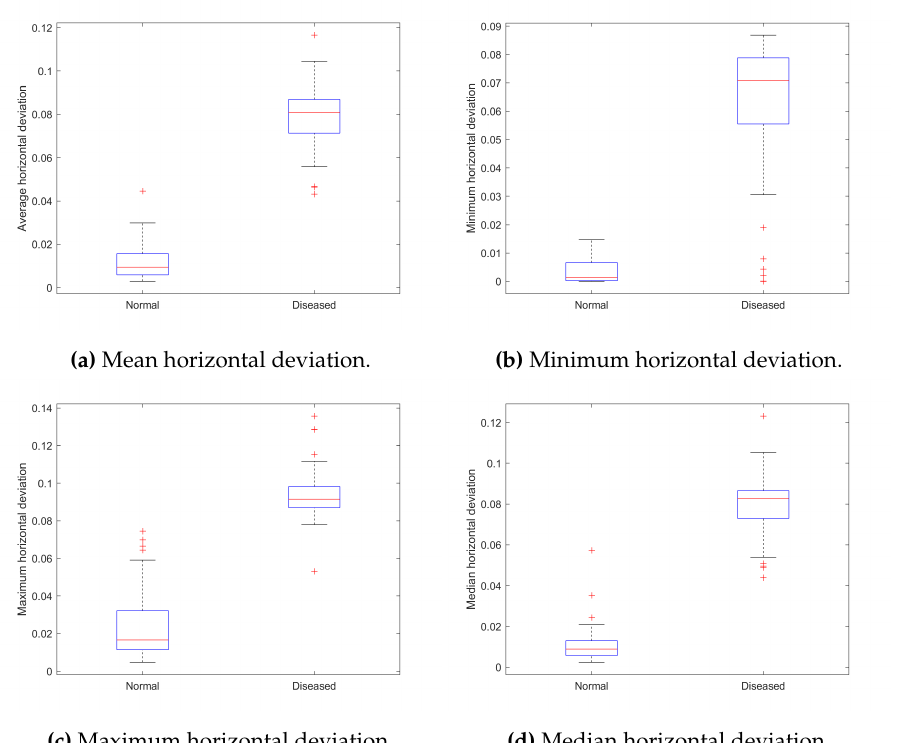
Figure 18. Summary of statistical characteristics of data for spine line: ( a ) Mean horizontal deviation, ( b ) Minimum horizontal deviation, ( c ) Maximum horizontal deviation, and ( d ) Median horizontal deviation.